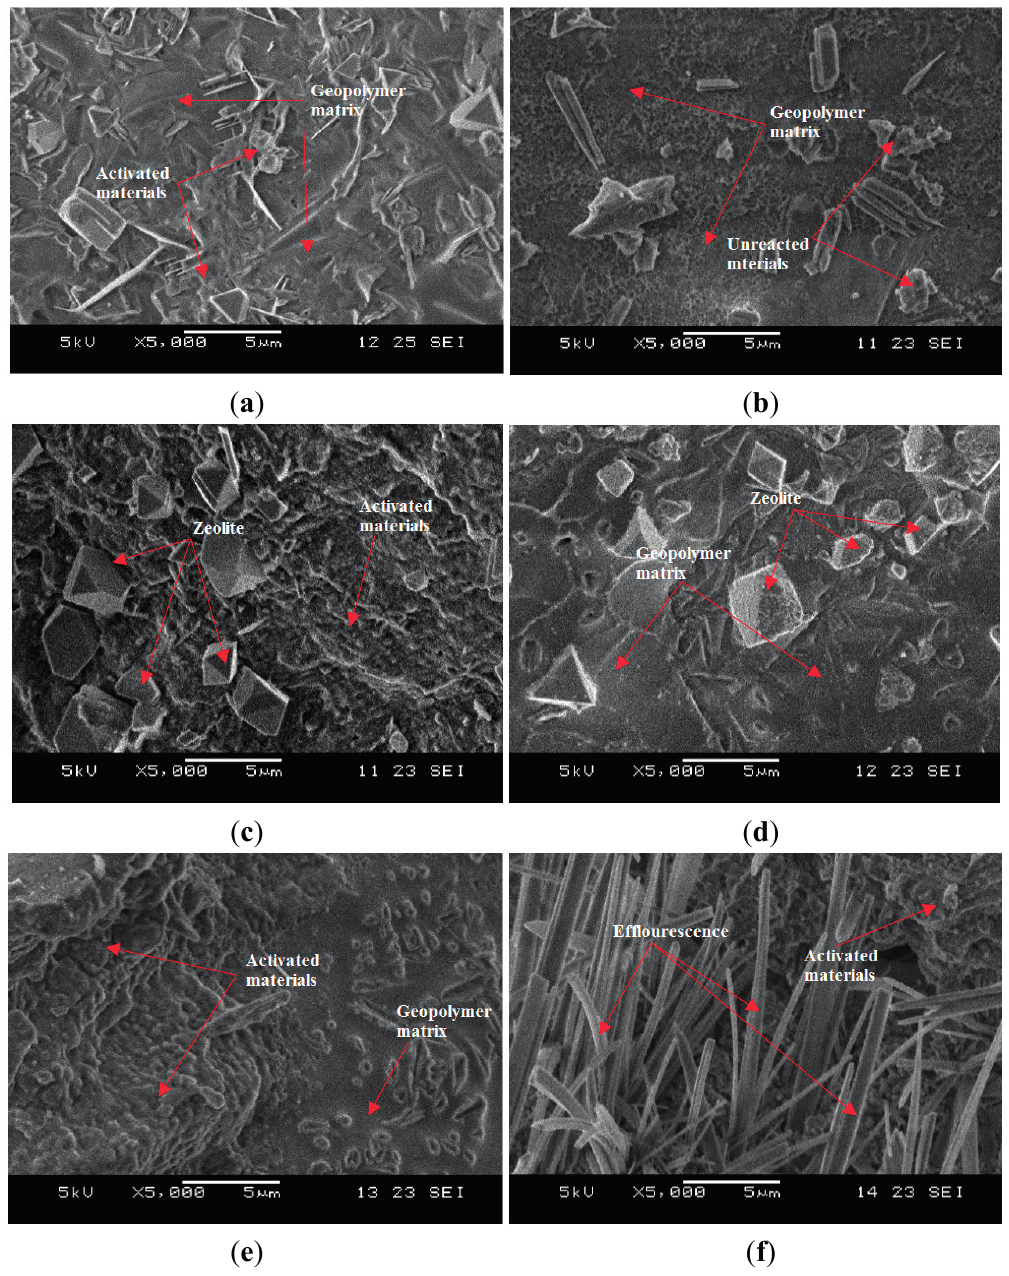
Figure 6. SEM micrograph of ALGA produced at various NaOH molarity, ( a ) 6 M; ( b ) 8 M; ( c ) 10 M; ( d ) 12 M; ( e ) 14 M; and ( f ) 16